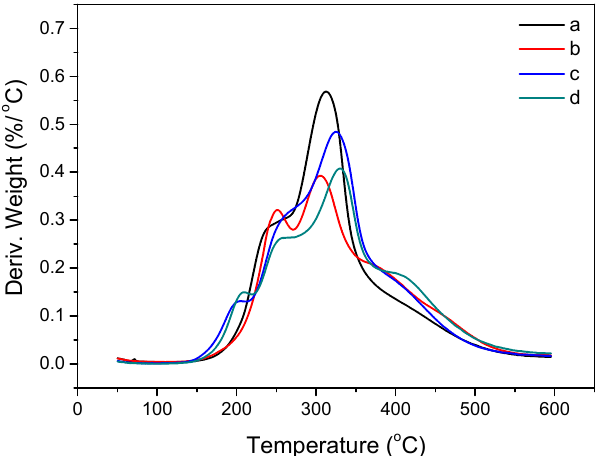
Figure 2. The derivative thermogravimetric (DTG) curves of the different adhesives: ( a ) SF adhesive; ( b ) SF/LB adhesive; ( c ) SF/PAE adhesive; and ( d ) SF/LB/PAE adhesive.